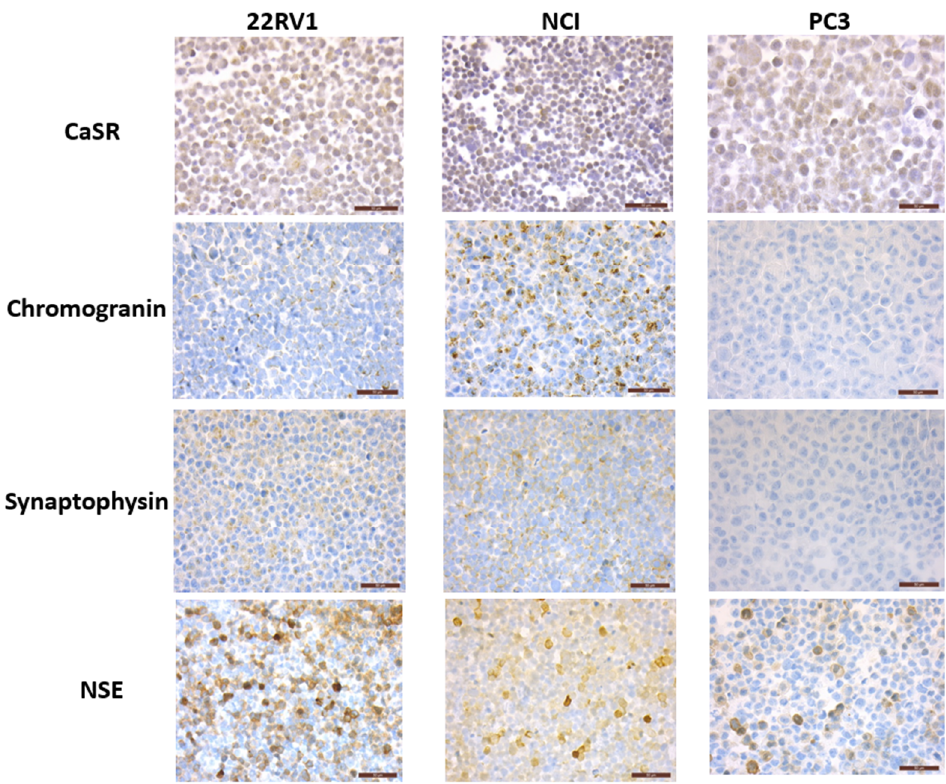
Figure 3. Expression of CaSR and neuroendocrine markers in NCI-H660, PC3 and 22RV1 cell lines. Immunohistochemical staining on cell pellets: all markers are expressed in NCI-H660 and 22RV1 cell lines, with nevertheless a weak expression of chromogranin in 22RV1. In PC3 cells, while both CaSR and NSE are expressed, no staining was observed for chromogranin and synaptophysin. NCI-H660, the only existing cell line derived from human NEPC, was used as reference. As